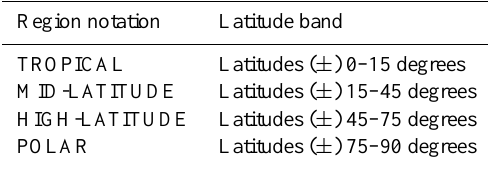
Table 2. Definition of geographical sub-regions.